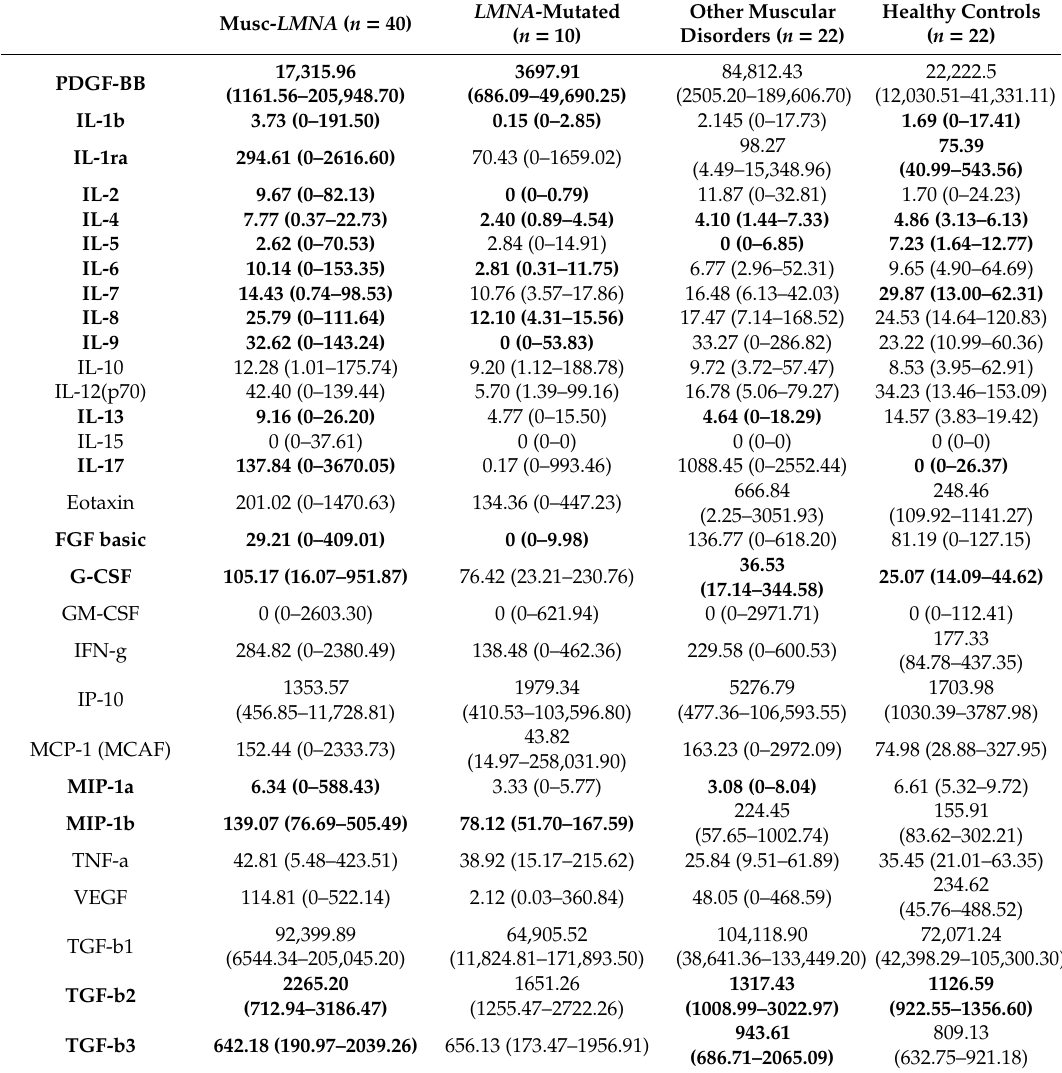
Table 2. Serum concentration of pro- and anti-inflammatory cytokines, chemokines and growth factors in patients and